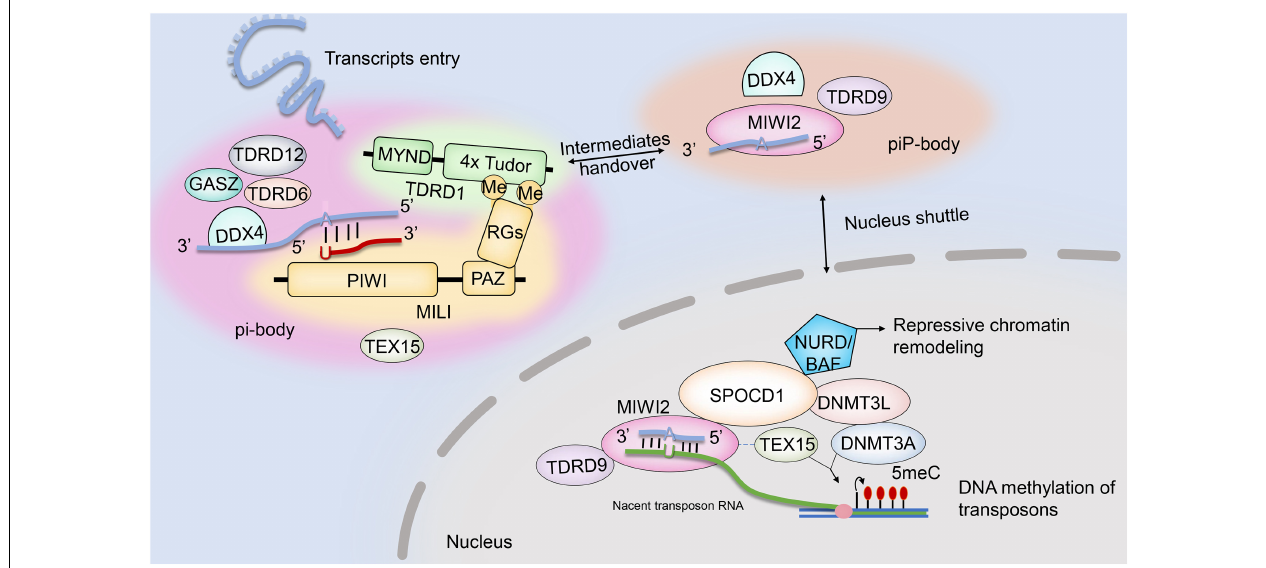
FIGURE 1 | Ping-pong cycle and MIWI2-piRNA-guided chromatin remodeling.